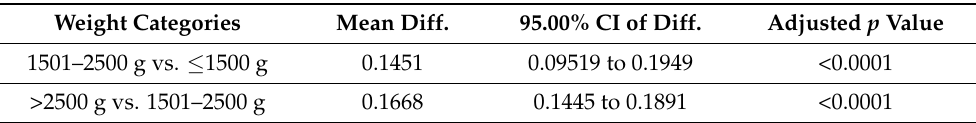
Figure 3. Box and whisker plot for TREC copy number by birth weight category. For the ≤ 1500 g category, N = 220; 1500–2500 g category, N = 1068 samples; >2500 g category, N = 6242. The line within each box and the numbers printed next to the box represent the median of each group. The top and bottom of each box are the 25 and 75 percentiles, respectively. The whiskers represent the range of TREC values. Table 1. One-way ANOVA of the log transformed TREC values for three weight groups shown in Figure 3, using multiple comparisons. Data were corrected for multiple comparisons using Šídák’s multiple comparisons test.